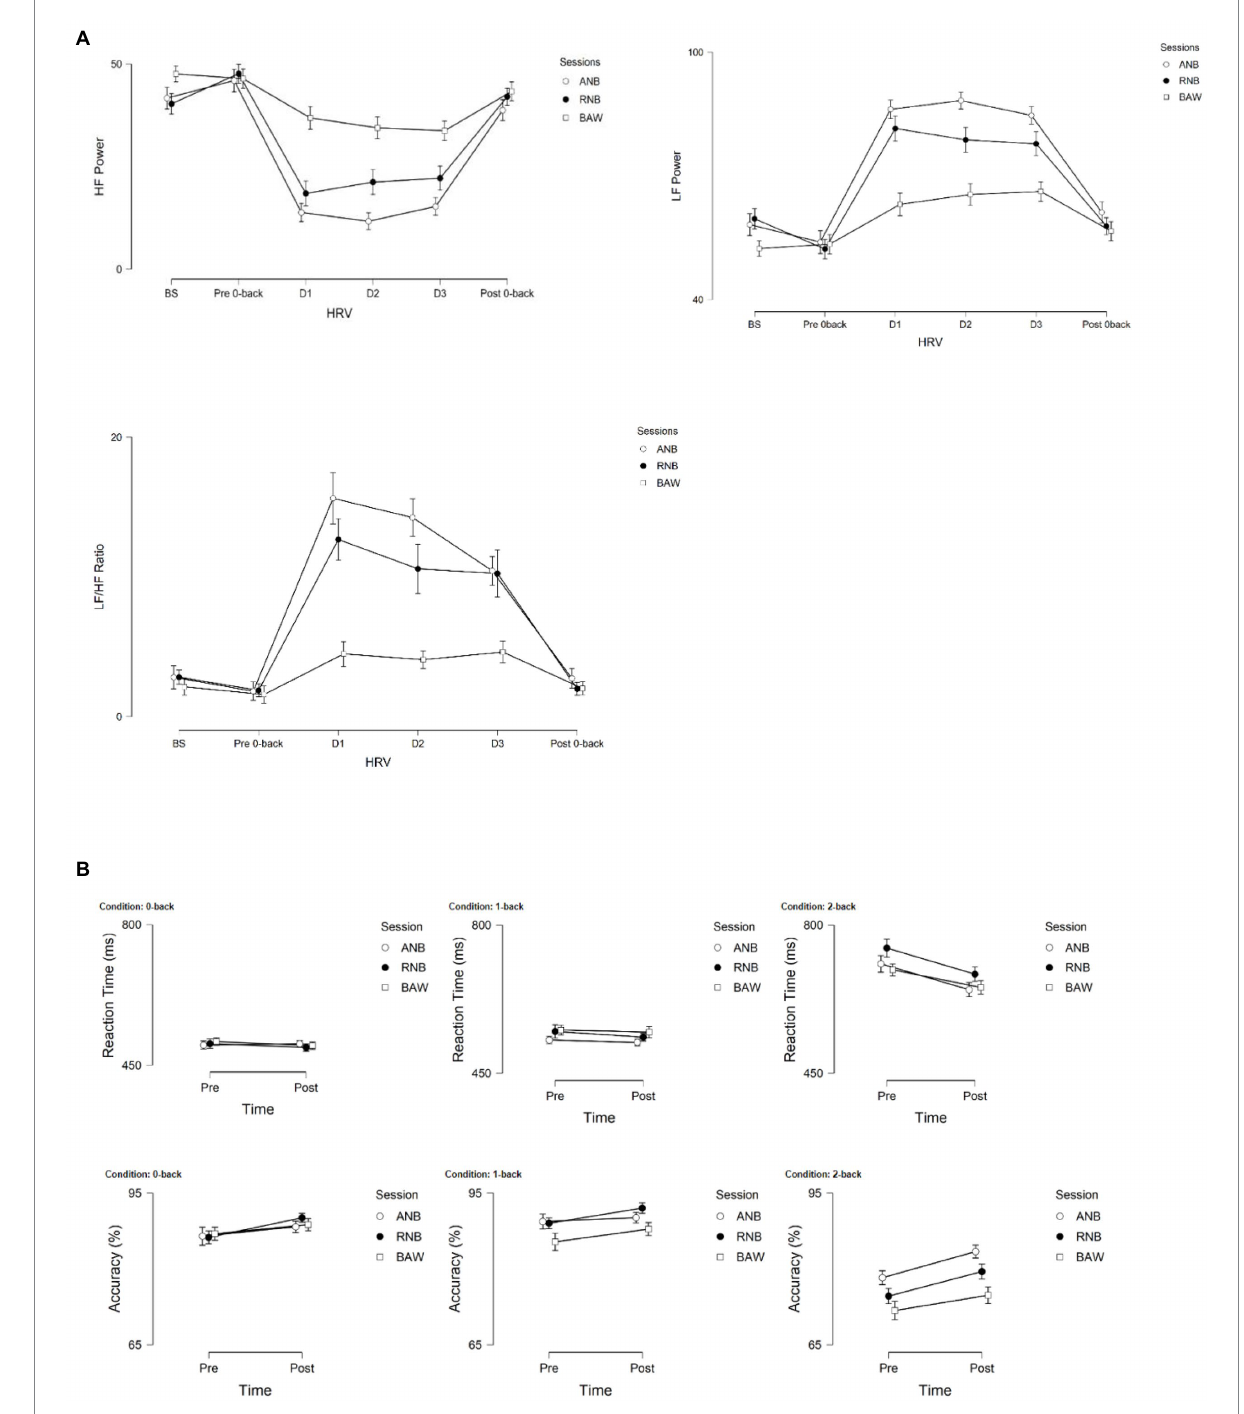
FIGURE 3 (A) Graphical representations of LF power, HF power, and LF/HF ratio during baseline, n-back (pre-post), and during SYB ( n = 40). (B) Reaction time (ms) and accuracy (%) of n-back conditions (0-, 1-, and 2-back) following